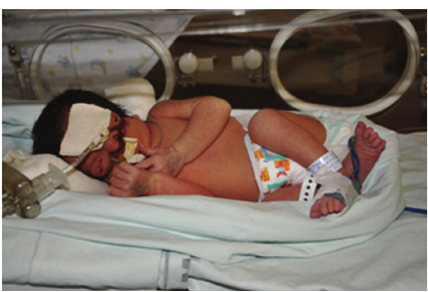
Figure 2: Image of the newborn showing micrognathia, maxil- lary hypoplasia, anophthalmia, bilateral auricular appendages, and severe